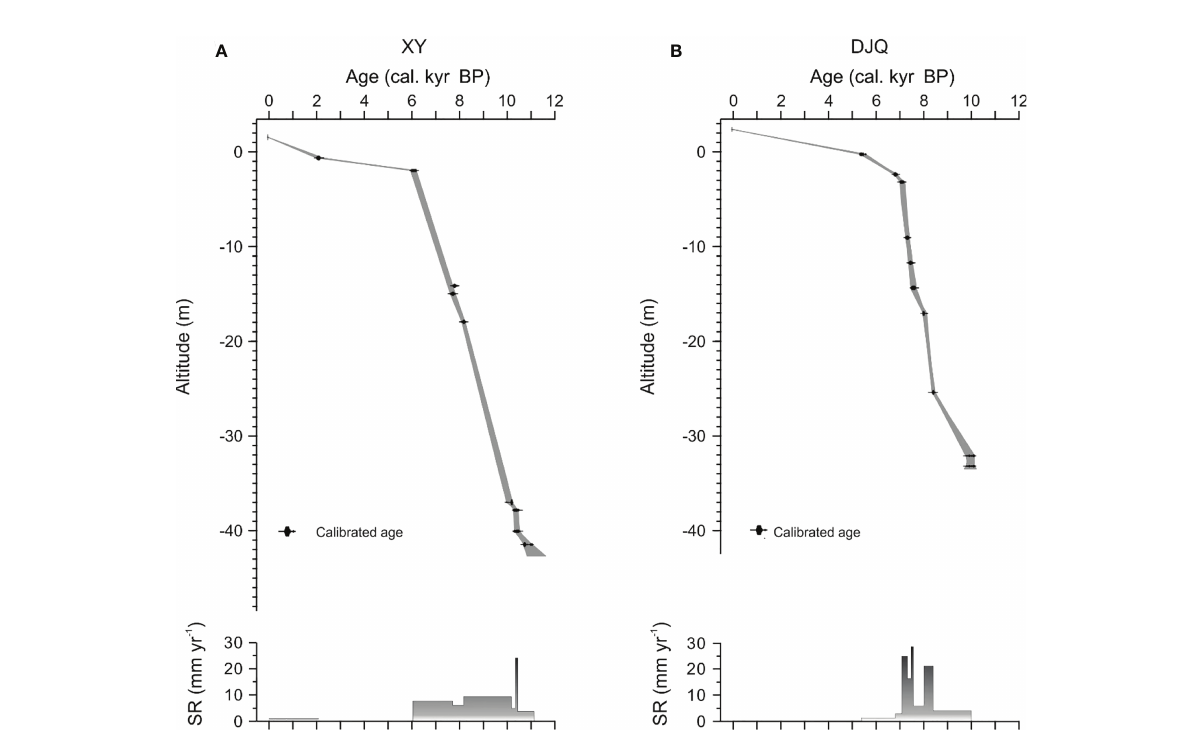
FIGURE 2 Age-depth models of cores XY (A) and DJQ (B) . The ages of the marine shell samples were inserted manually, as the Clam software does not facilitate the inclusion of terrestrial and marine samples in the model. Changes in sedimentation rate (SR) in each core are also